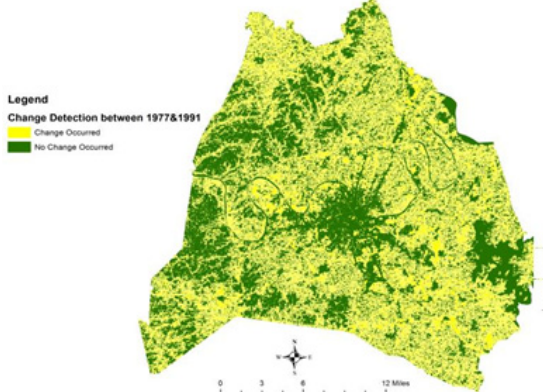
Fig. 7: Change detection areas between 1977 and 1991